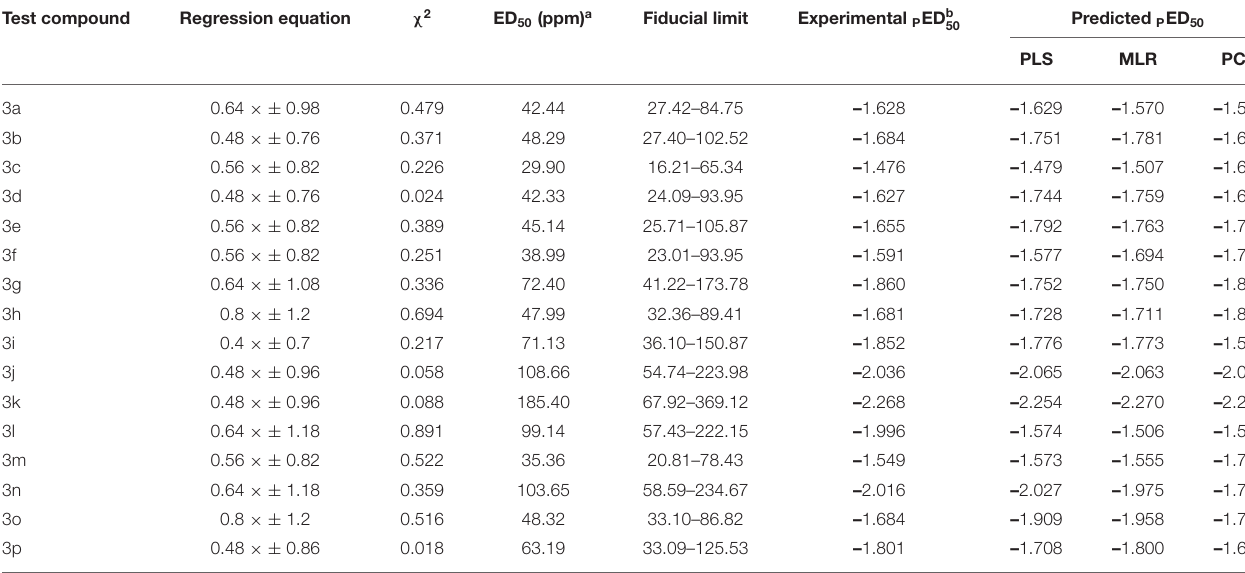
Table 3A | Experimental and predicted fungicidal activity of ferrocenyl chalcones against A. solani . Test